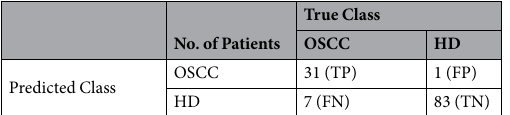
Table 3. Confusion matrix for classification of OSCC classifier. HD, healthy donors. OSCC, patients with OSCC. True Class, the actual clinical status of the subjects. Predicted Class, the predicted clinical status of the subjects using the algorithm. TP, true positives. FP, false positives. FN, false negatives. TN, true negatives. Sensitivity, TP/(TP + FN) = 81.6%. Specificity, TN/(TN + FP) = 98.8%. Precision or positive predictive value (PPV), TP/(TP + FP) = 96.9%. Negative predictive value (NPV), TN/(TN + FN) = 92.2%. ACC, (TP + TN)/ (TP + FP + FN + TN) = 93.4%.